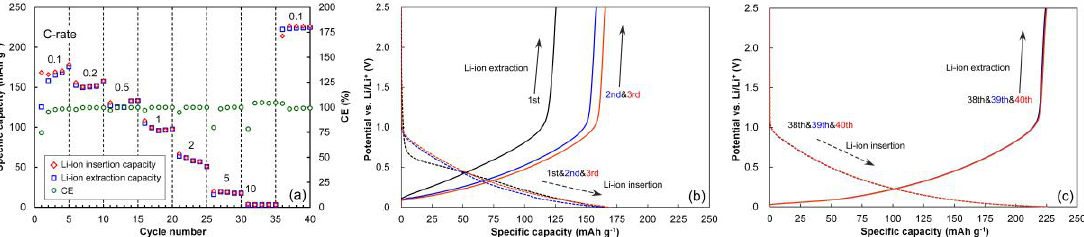
Figure 3. Li-ion insertion-extraction properties of the HC electrode at various C-rates: ( a ) the specific capacity and the CE at 0.1–10 C-rate; ( b ) the potential profiles of the first to third cycles at 0.1 C-rate; ( c ) the potential profiles of the 38th to 40th cycles at 0.1 C-rate. The cut-off potential range was 0–2.5 V vs. Li/Li + ; 1 C-rate is equal to 200 mA g −1 .